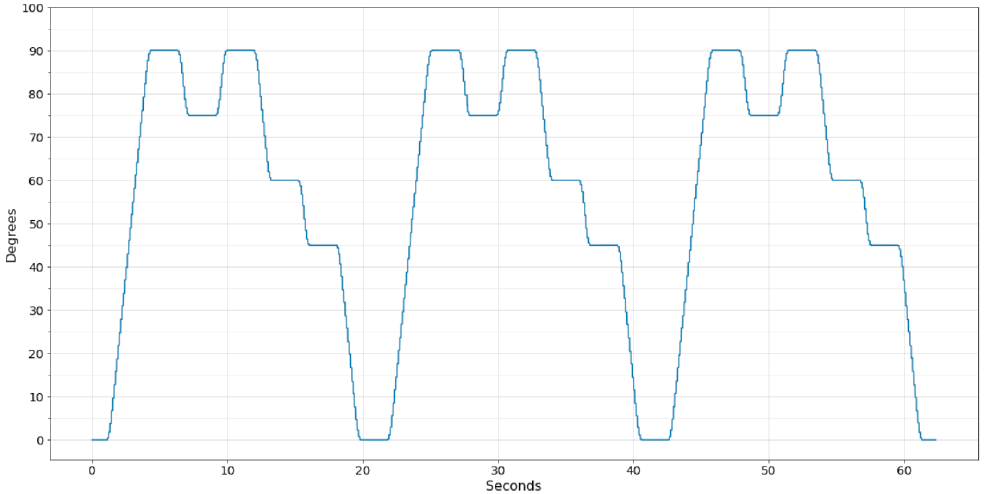
Figure 9. Movement performed by the UR3